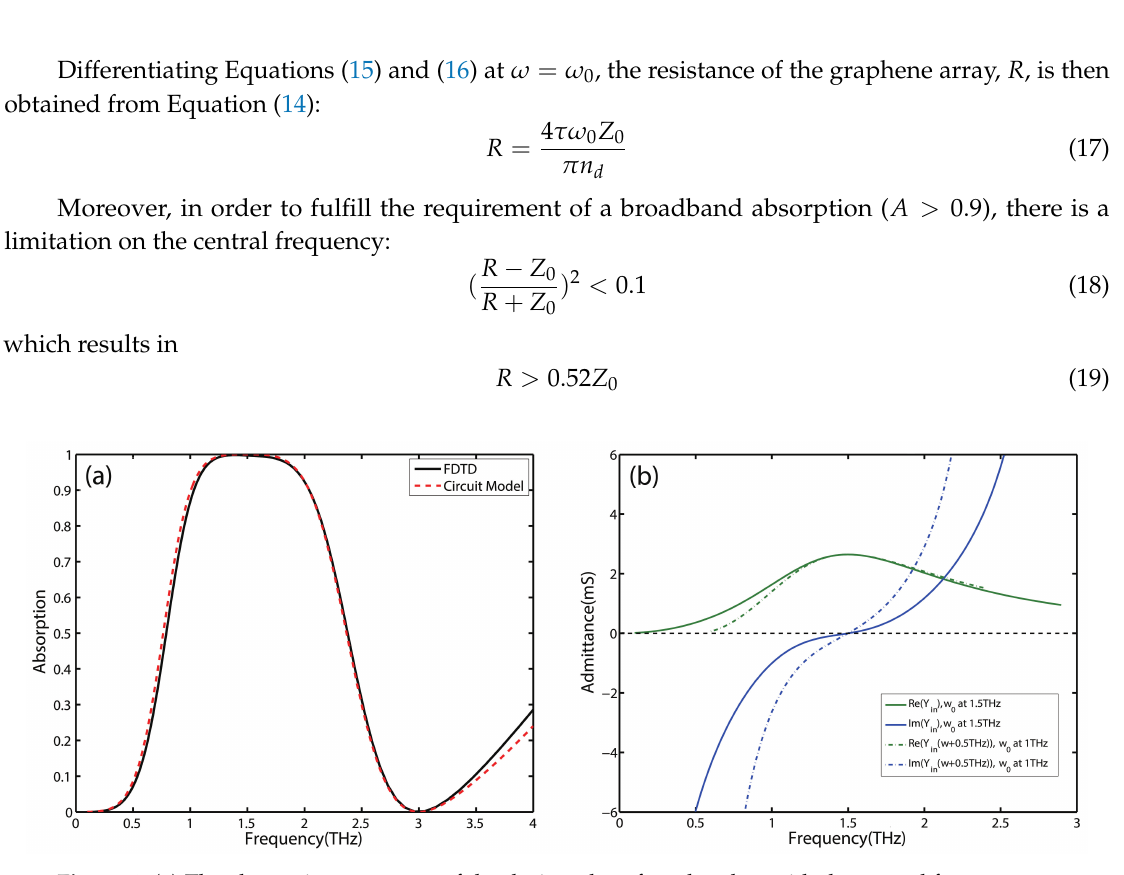
Figure 4. ( a ) The absorption spectrum of the designed perfect absorber with the central frequency at 1.5 THz simulated by FDTD simulations and calculated by circuit model. ( b ) The trends of real and imaginary of the input admittance of the designed absorber with the central frequency at 1.5 THz vs. that of the prefect absorber with the central frequency at 1